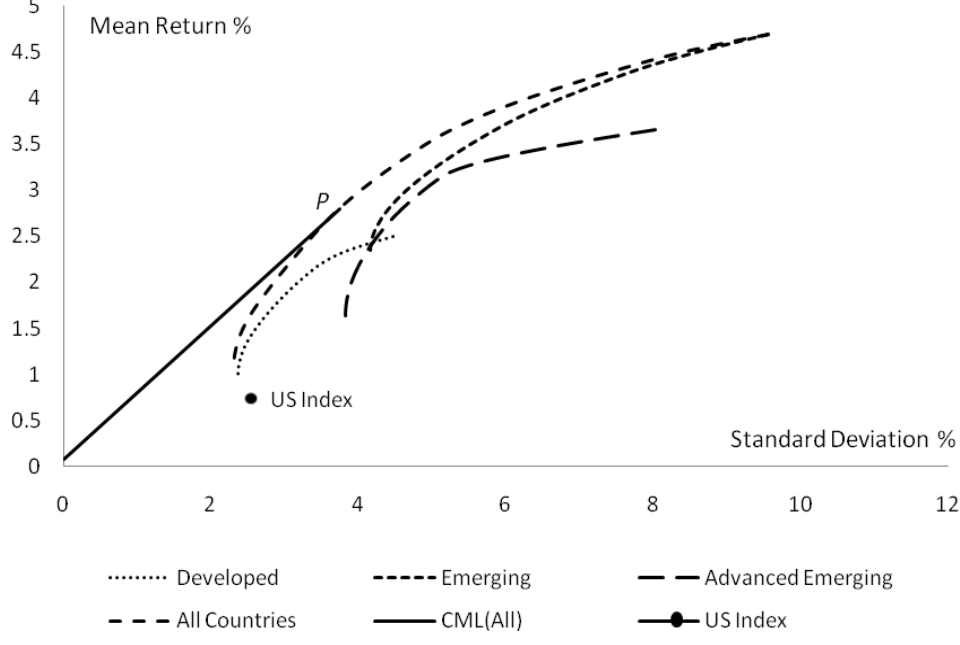
Figure 1. Pre-Crisis Portfolio Frontiers by Sub-Sample of Countries